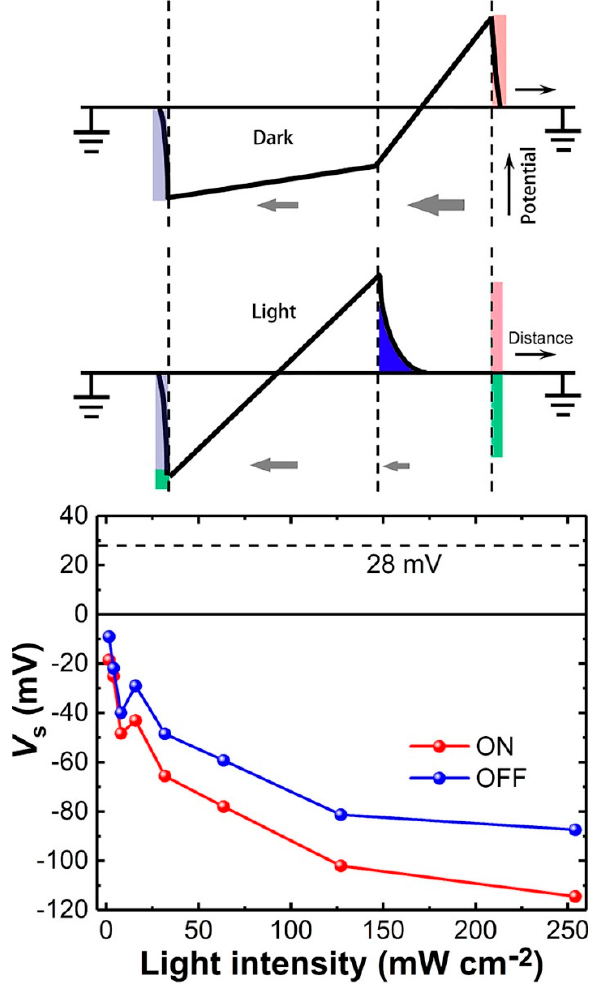
Figure 5. Light intensity dependence of the photoinduced voltages ( V s ) drop across the SL capacitor. The inset is a schematic view for the MISM device under dark and light conditions.